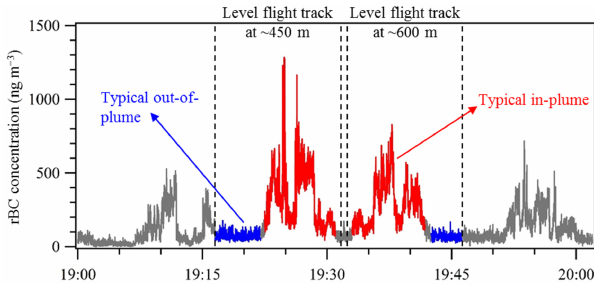
Figure 9. Identification of typical in- and out-of-plume conditions for two level flight tracks at ∼ 450 and 600m (in terms of ellipsoid height, equivalent to ∼ 150 and 300m above ground) on the first virtual screen of the transformation flight F_9/4.